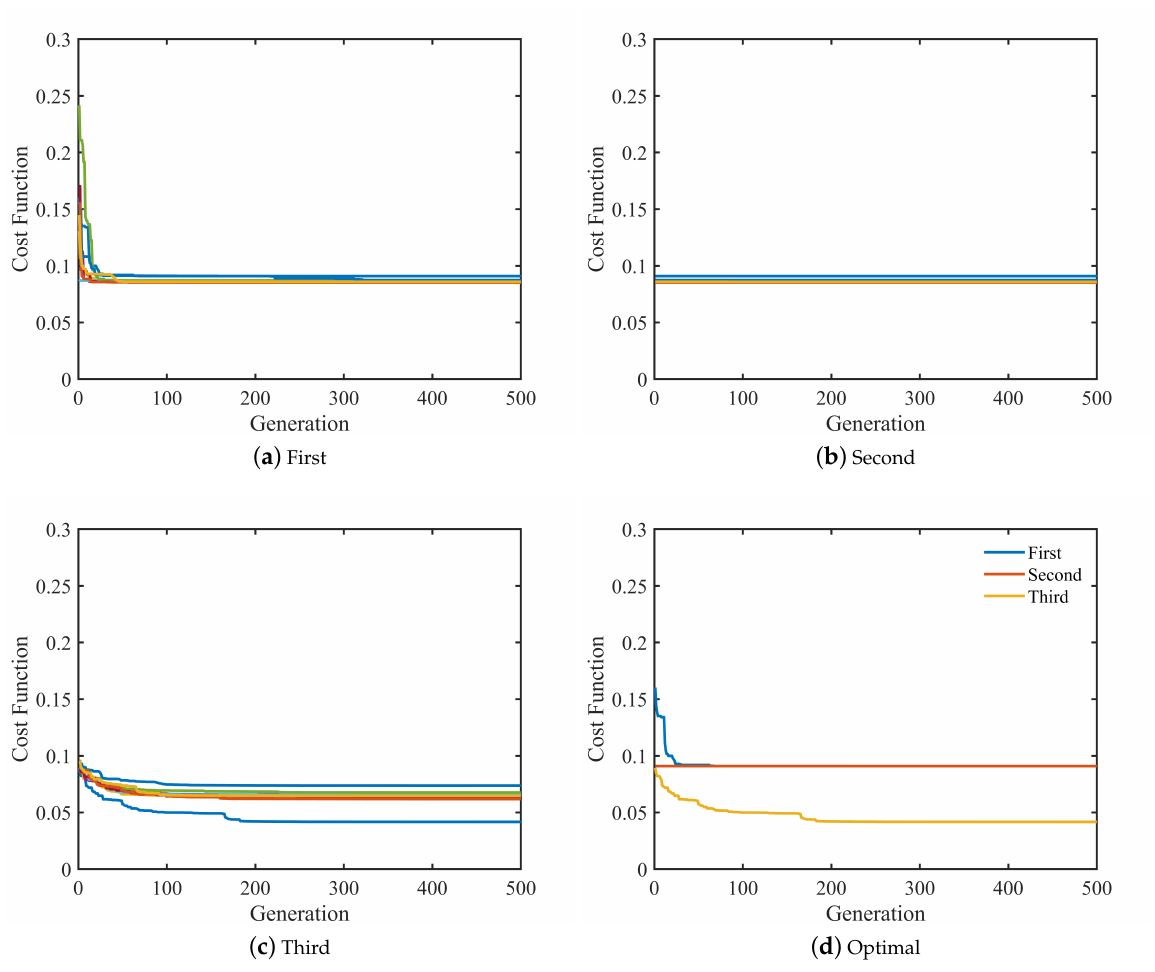
Figure 5. Three-level optimization process based on the BBPSO algorithm. Convergence values of three-level optimization are compared as Figure 6. Since the results are similar in all four months, only the results in March are presented.